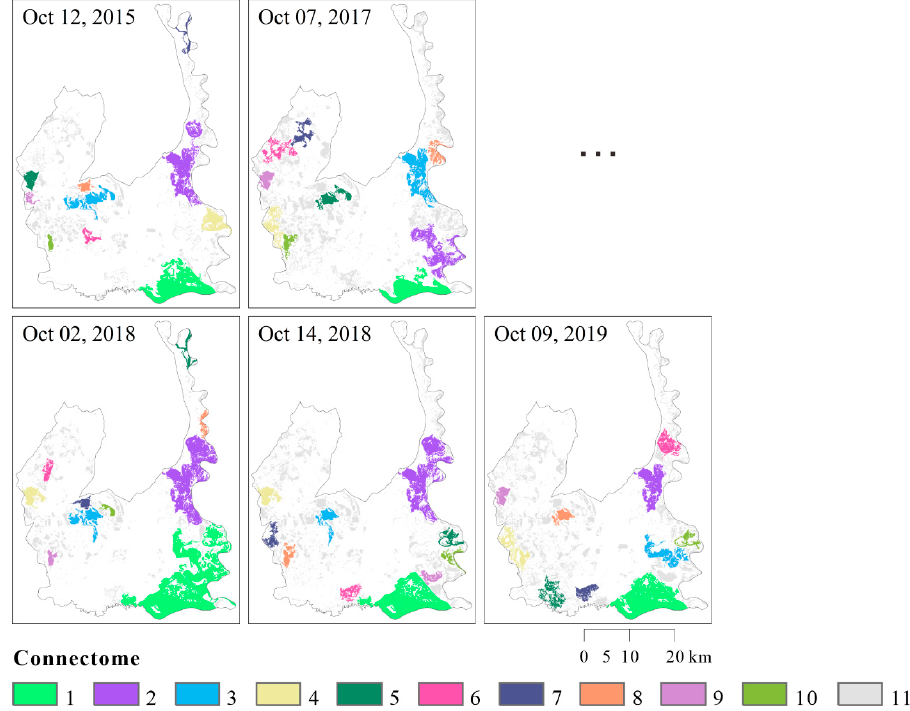
Figure 14. Spatial distribution of the connectomes (i.e., seasonally connected water bodies) in China’s Momoge National Nature Reserve in October. Colors 1 to 10 in the legend refer to the top ten largest connectomes, and color 11 refer to the remaining connectomes and isolated water bodies.